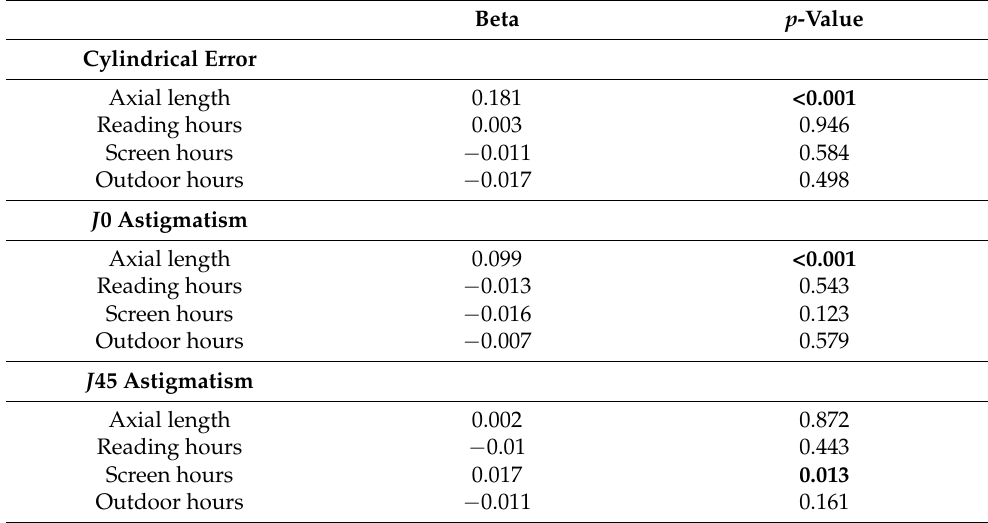
Table 3. Multiple linear regression models for prediction of cylindrical power, J 0, and J 45